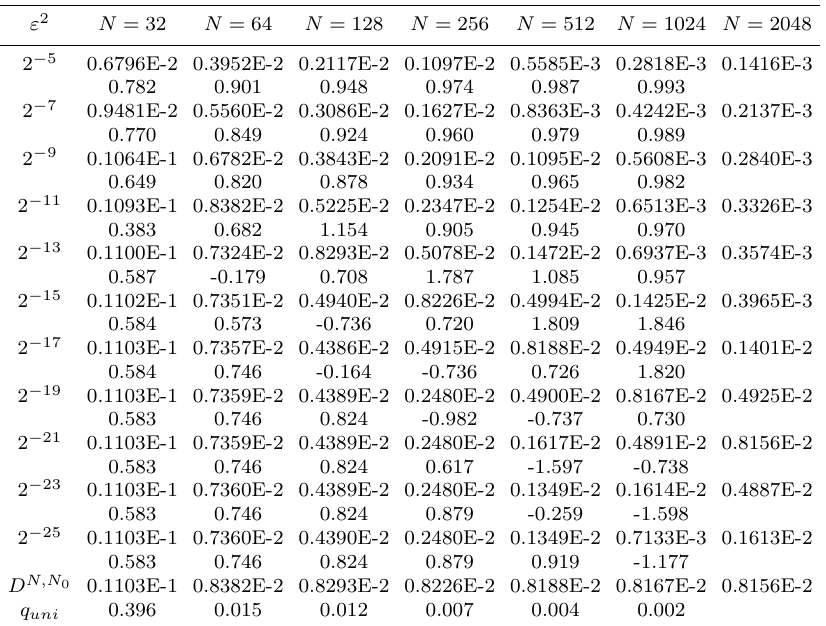
Table 1. Maximum errors and orders of convergence on a uniform mesh for problem (4.1),